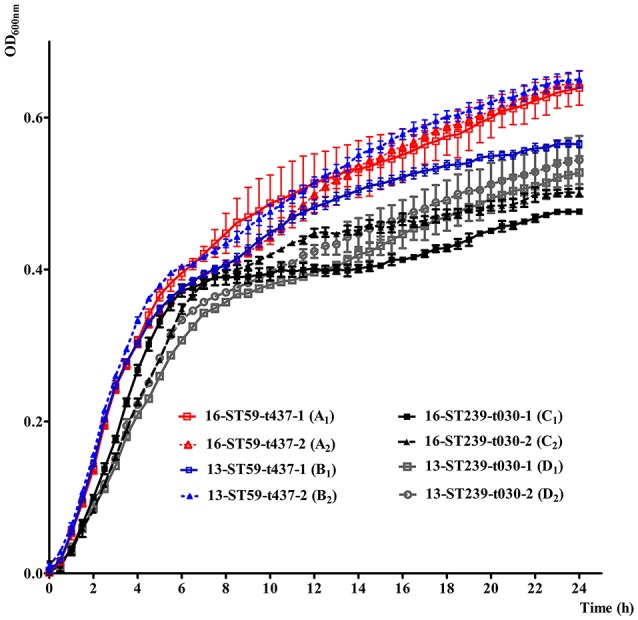
In vitro growth characteristics of random selected ST59-t437 and ST239-t030 meticillin-resistant Staphylococcus aureus (MRSA) isolates cultured at 37°C in LB broth. The means and standard deviation of three independent experiments are shown. The abbreviated codes (A1, A2, B1, B2, C1, C2, D1 and D2) for the isolates are listed in the brackets. Among the pairwise comparison of growth curves, A1C1, B2C1, and B2D1 showed significant statistical differences (P < 0.05), when using one-way analysis of variance (ANOVA) followed by Tukey–Kramer tests.